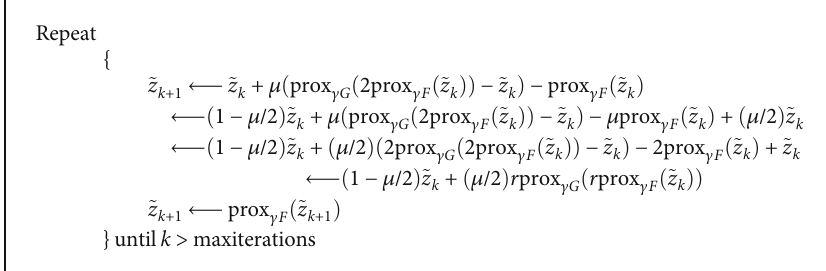
methods: reg-KM, Chan-Vese, and the proposed DR. In case of all images, the proposed DR algorithm achieves signi fi